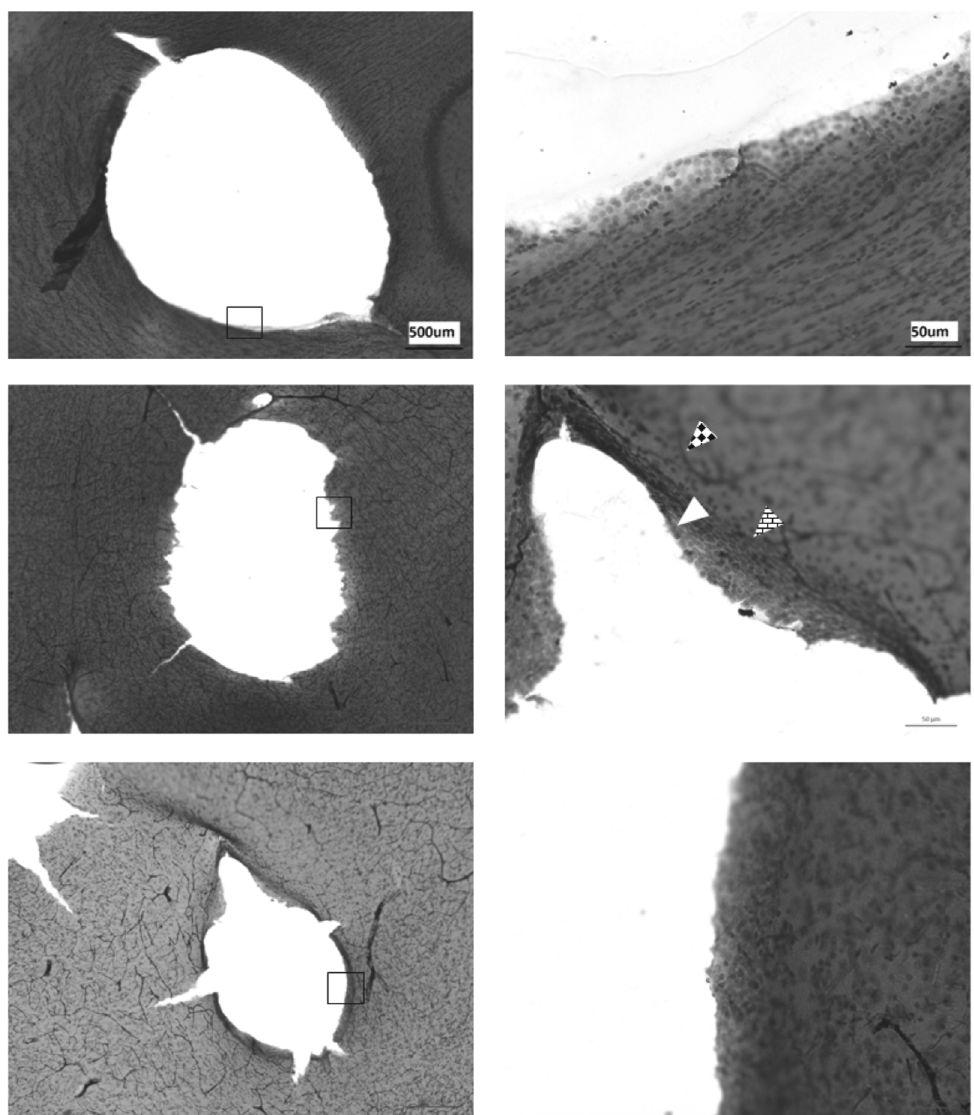
Figure 4. Representative histological sections at respective arteries of fistula SHR. Top panel: ICA, middle panel: MCA and bottom panel: ACA. Left pictures were taken at 10x magnification. Squares in the left panel indicate ROI magnified on the right magnified at 40x. Unfilled triangle shows endothelium. Diamond filled triangle shows elastin lamellae. Brick filled triangle shows basement membrane. All images follow the same scale bar of the image in their corresponding top panel.